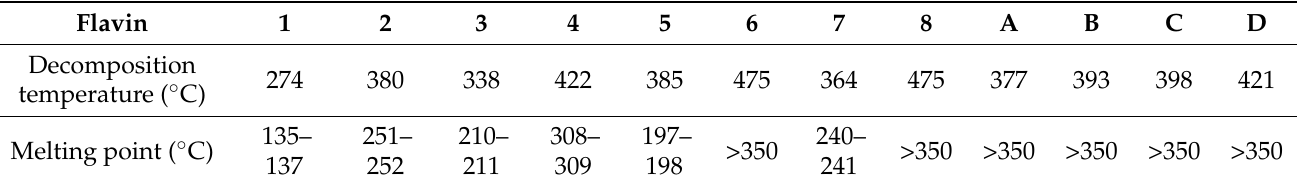
Table 1. Data from TGA measurements and melting points for the alkylated flavins ( 1 – 8 ) and the unsubstituted derivatives ( A – D ). The decomposition temperature is reported as the temperature at the steepest point (1st derivation) of the TGA curve (see